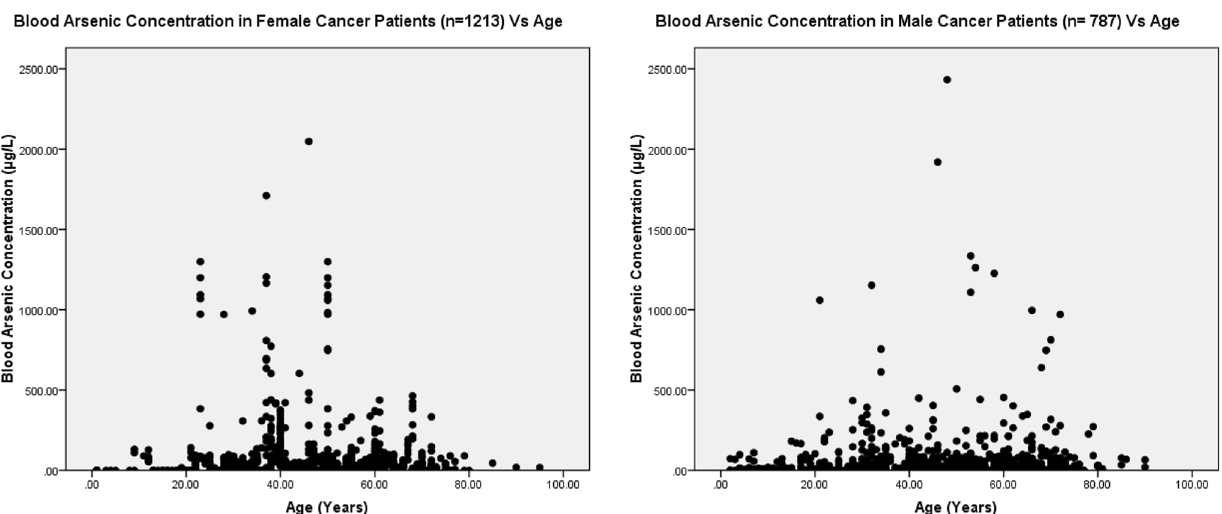
Figure 6. Arsenic concentration in blood samples of male patients were analyzed through GF-AAS (ANOVA- Dunnett’s Test, P < 0.05).